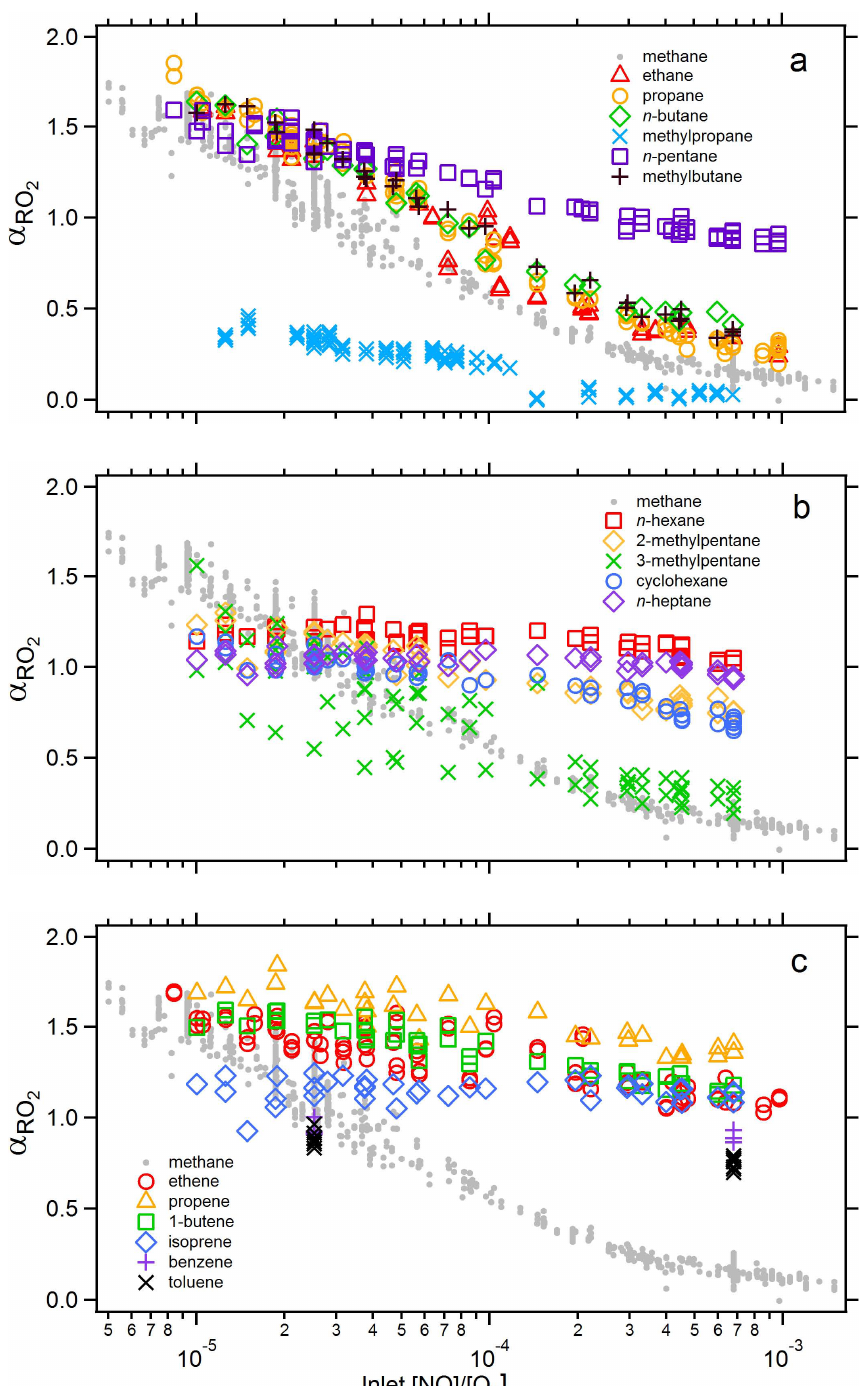
Fig. 8. Plots of α RO for RO 2 formed from (a) C 2 -C 5 (i.e. having between two and five carbon atoms) alkane precursors (b) C 6 -C 7 alkane 2 precursors and (c) unsaturated hydrocarbon precursors against the ratio of [NO]/[O 2 ] in the inlet. For comparison, measured α CH are included on each